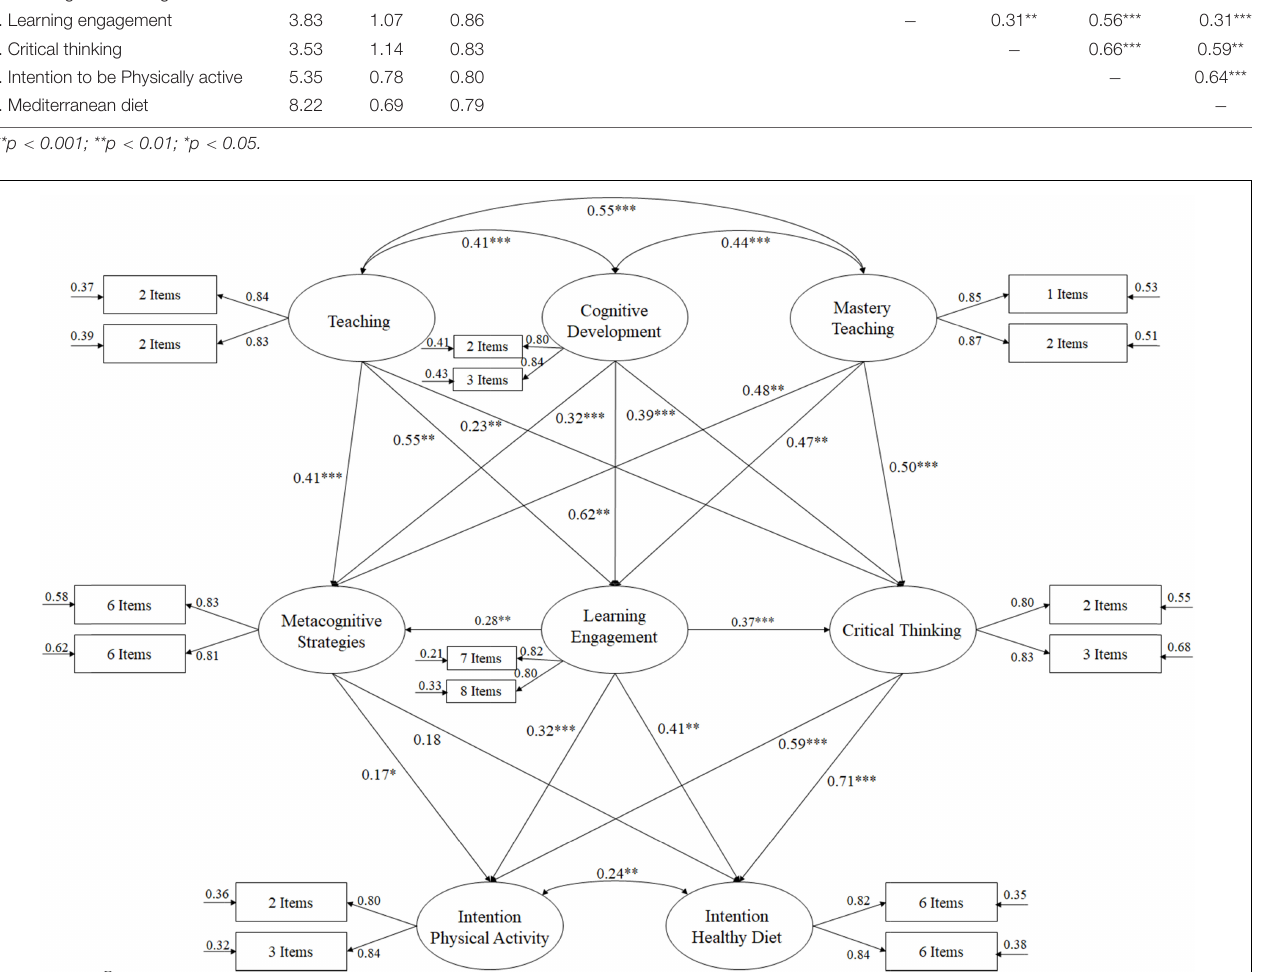
FIGURE 1 | Structural equational modeling. ∗∗∗ p < 0.001; ∗∗ p < 0.01; ∗ p <